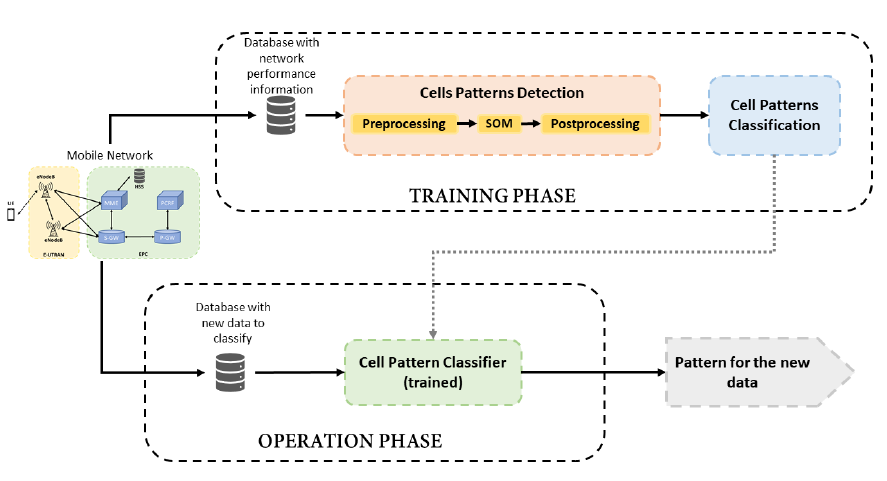
Figure 1. Block diagram of the proposed